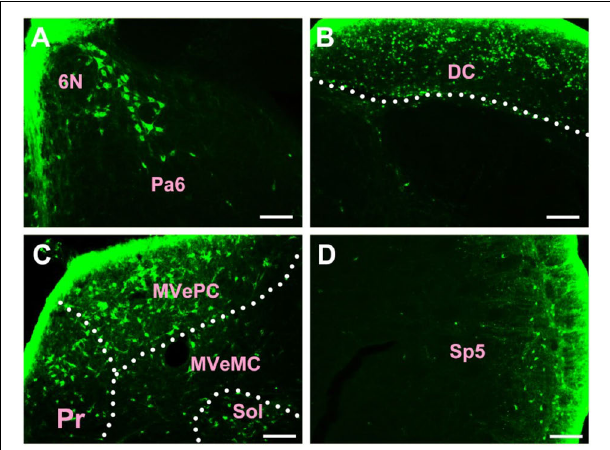
FIGURE 6 | The distribution of neurons labeled by CB in the medulla oblongata Part I (A–D) . 6N, abducens nucleus; Pa6, paraabducens nucleus; DC, dorsal cochlear nucleus; Pr, prepositus nucleus; MVePC, medial vestibular nucleus parvicellular part; MVeMC, medial vestibular nucleus magnocellular part; Sol, solitary nucleus; Sp5, spinal trigeminal nucleus. Scale bar = 100 µ m.